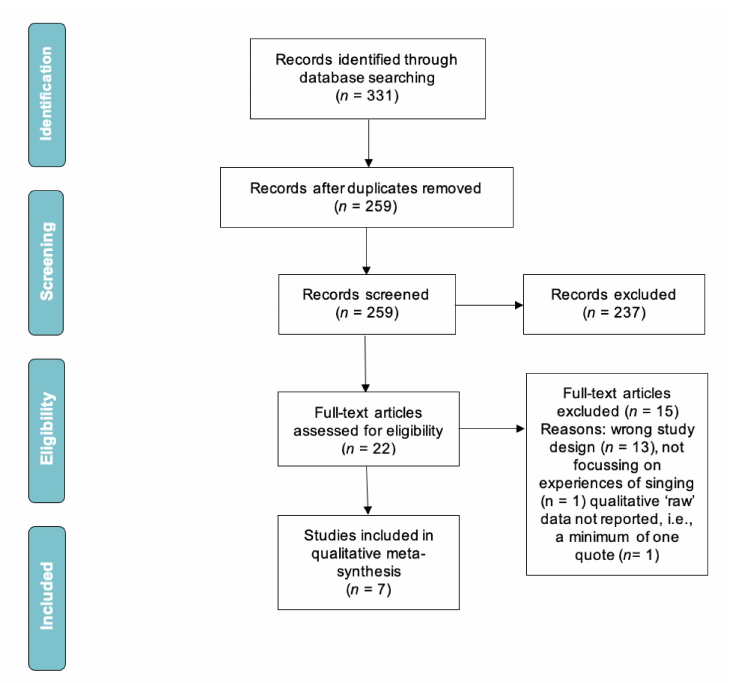
Figure 1. PRISMA